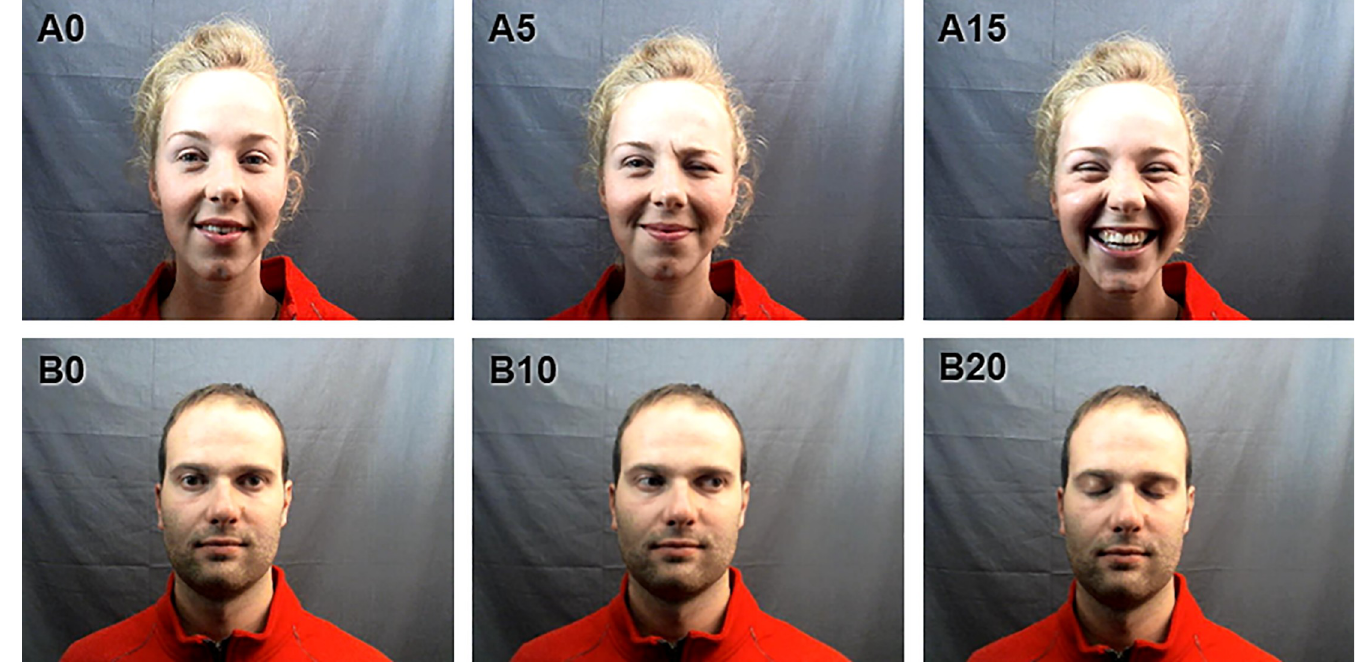
Fig 1. Snapshots of video clips. In video clip A (upper panels), the confederate first looks directly into the camera ( A0 ). After 5 seconds, the confederate frowns and smiles and then resumes looking into the camera ( A5 ). After 15 seconds, the confederate laughs and then resumes looking into the camera again ( A15 ). Finally, after 25 seconds the confederate winks and smiles. In video clip B (lower panels), the confederate first looks directly into the camera with a neutral expression ( B0 ). After 10 seconds ( B10 ), the confederate averts his gaze to the right for about 5 seconds. Then, after 20 seconds, the confederate briefly closes his/her eyes and then looks back into the camera again ( B20